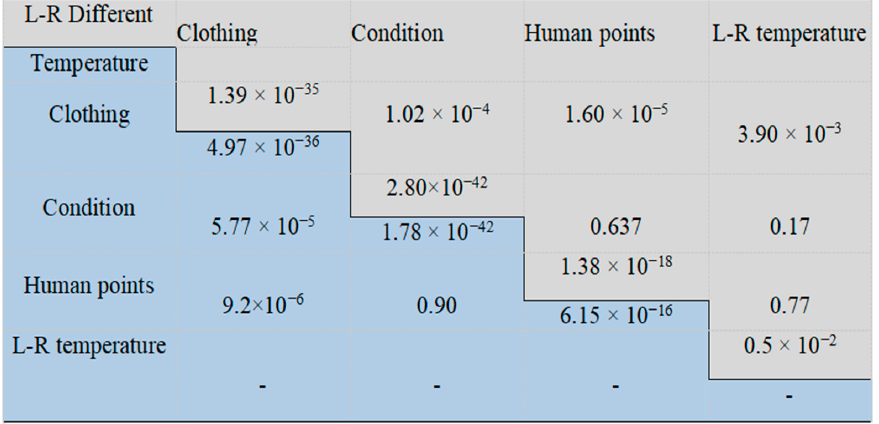
Figure 17. The multi-factor ANOVA on the temperature distribution and difference between left and right.